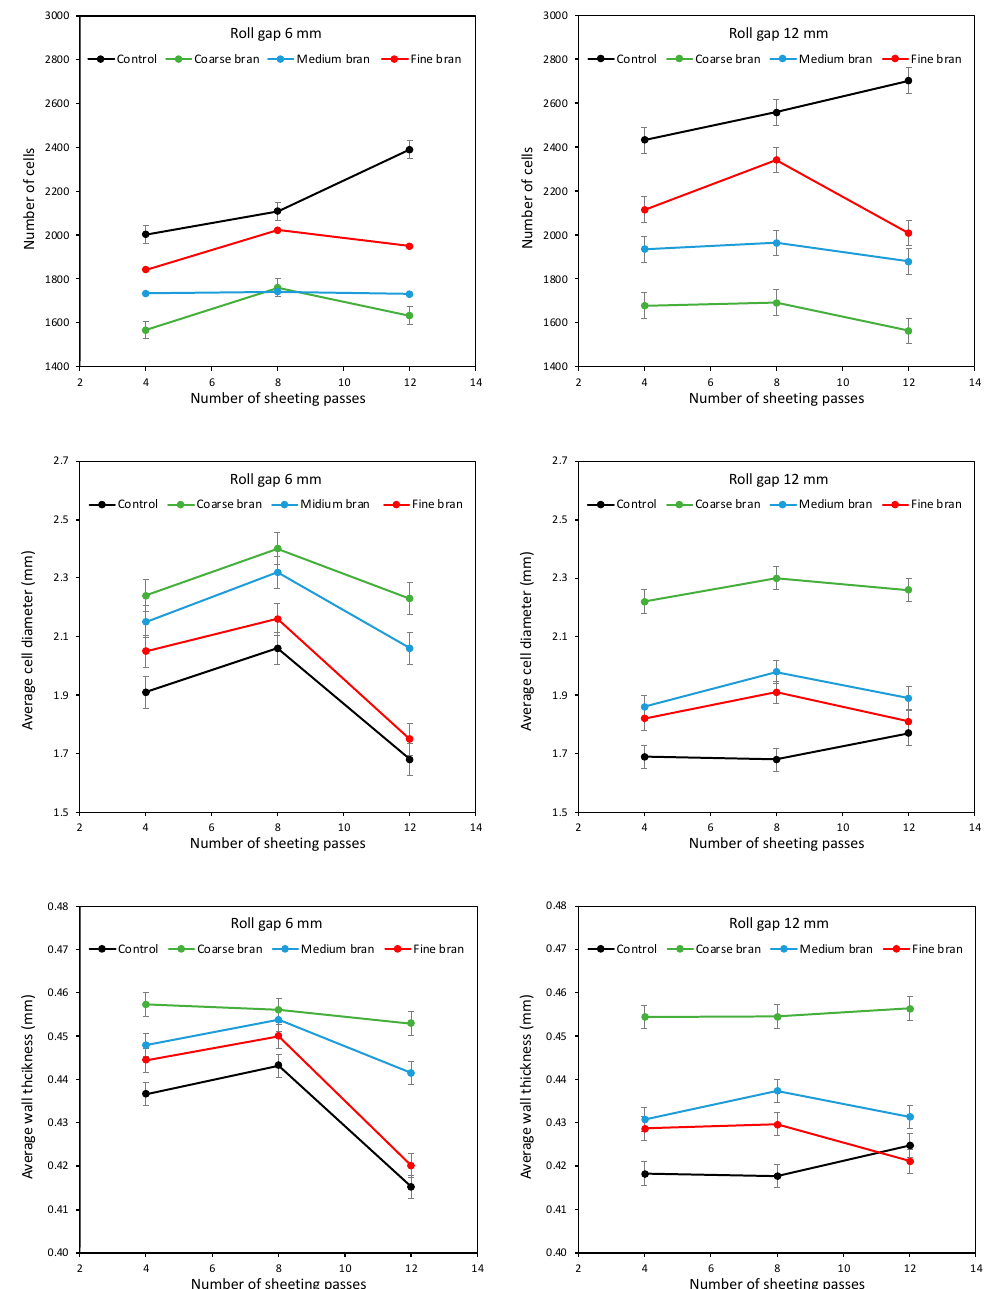
Figure 12. Average number of cells ( top ), average cell diameter ( middle ) and average wall thickness ( bottom ), for baked loaves containing 10% Coarse, Medium and Fine bran, sheeted at roll gaps of 6 mm ( left ) and 12 mm ( right ) for 4, 8 and 12 sheeting passes.